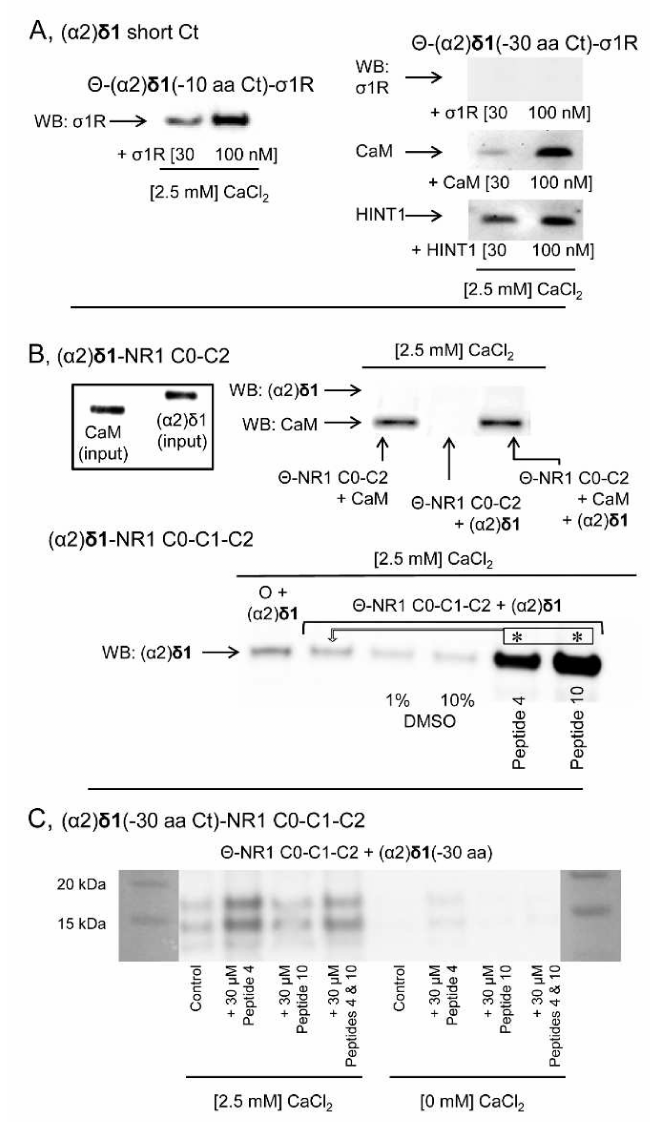
Figure 8. The C terminal sequence of the ( α 2) δ 1 peptide binds to σ 1Rs and NMDAR NR1 C1 subunits. ( A ) Immobilized ( α 2) δ 1 C terminal truncated sequences (–10 or –30 aa) were incubated with σ